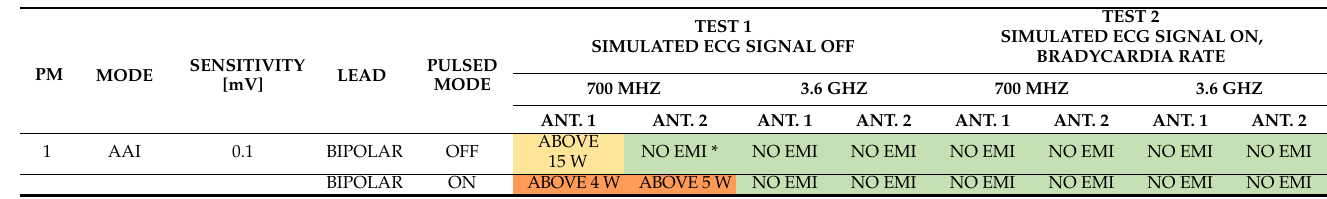
Table 4. PM results, bipolar sensing (power threshold levels are reported rounded to the nearest integer in terms of